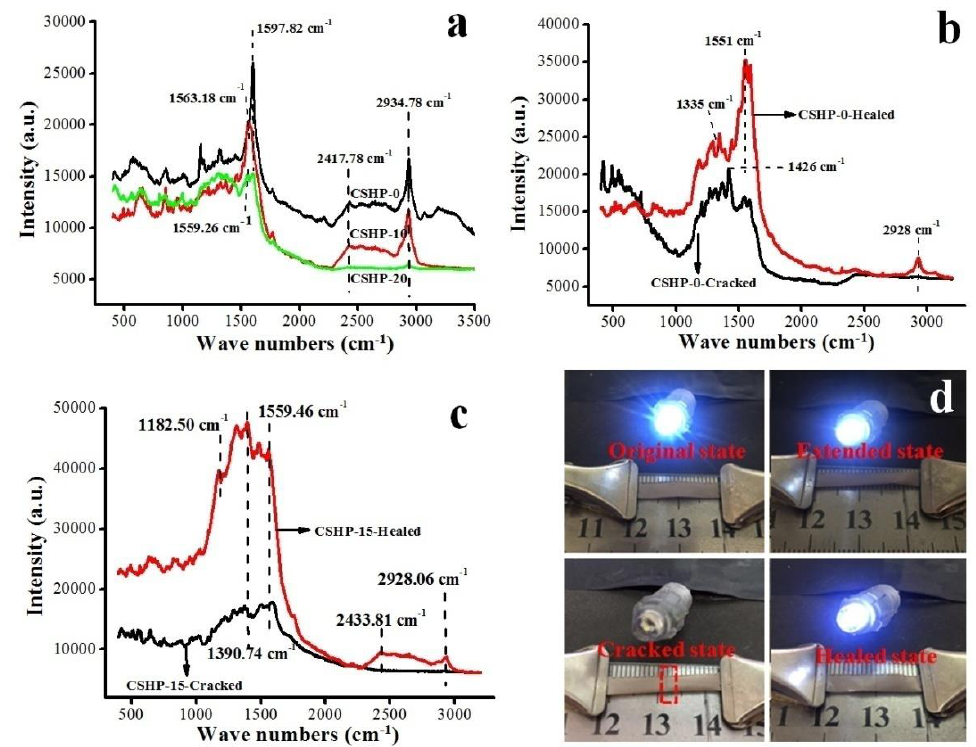
Figure 3. Raman spectra of the crack-free sample in different pre-stretched states ( a ), the local area in the cracked and healed states without ( b ) and with the pre-stretching( c ); ( d ) Photographical demonstration of the shape memory-enhanced self-healing.